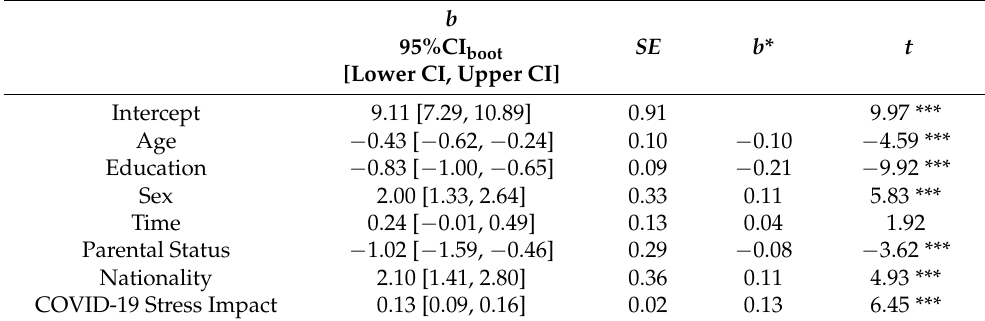
Table 4. Second step of the hierarchical linear regression of COVID-19 stress impact on depressive symptoms.